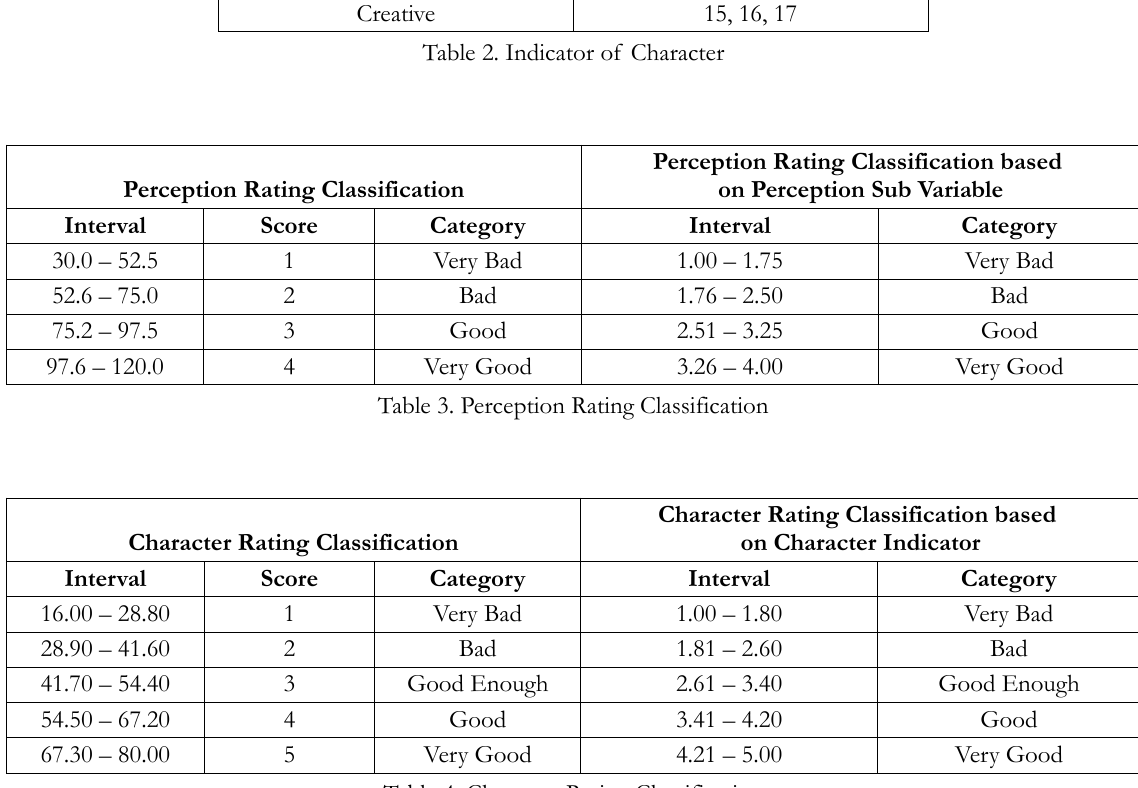
Table 4. Character Rating